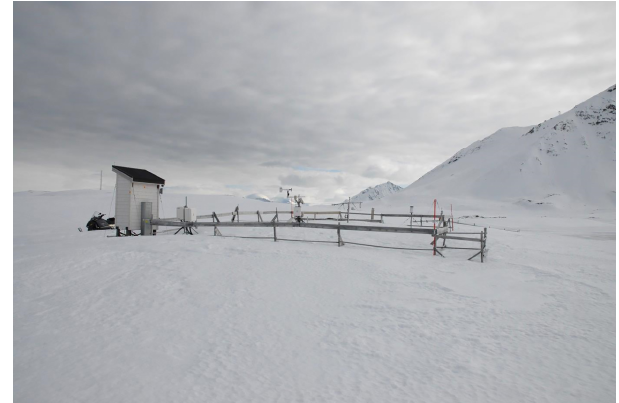
Figure E1. The Bayelva site covered by snow, 7 May 2016.